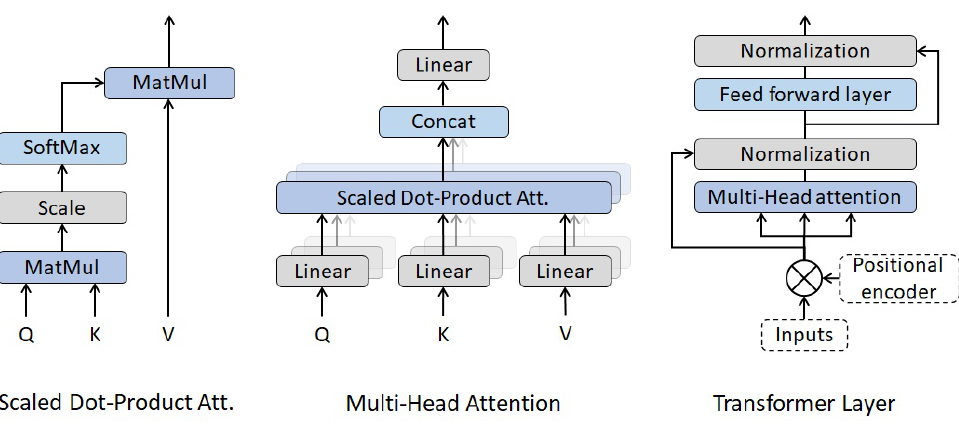
Figure 3. Transformer and Multi-Head attention